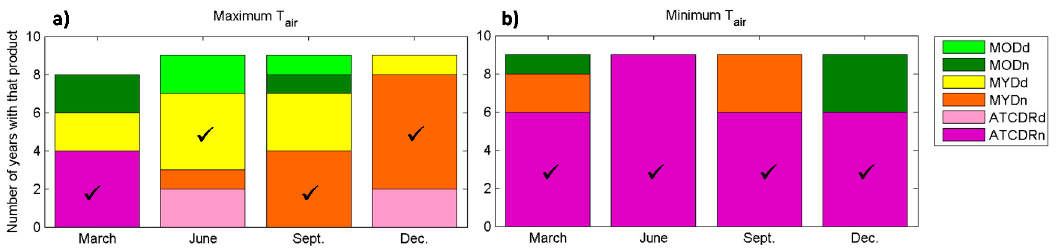
Figure 3. Statistics showing the product providing the best estimates of maximum ( a ) and minimum ( b ) T air (in terms of RMSE A ). Results from regressions considering 80 common meteorological stations for the years 2003–2011. For years 2012–2015 without the ATCDR product, LST products providing the best estimates were MYDd for maximum T air in March and June, and MYDn for the other